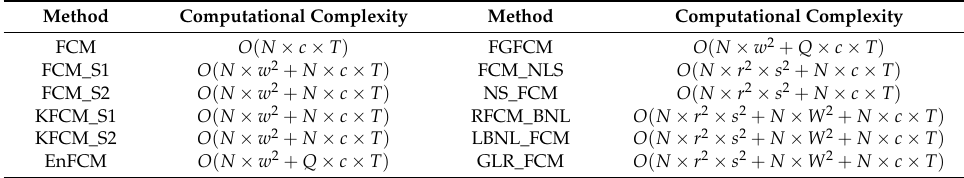
Table 6. The computational complexity of algorithms used in this